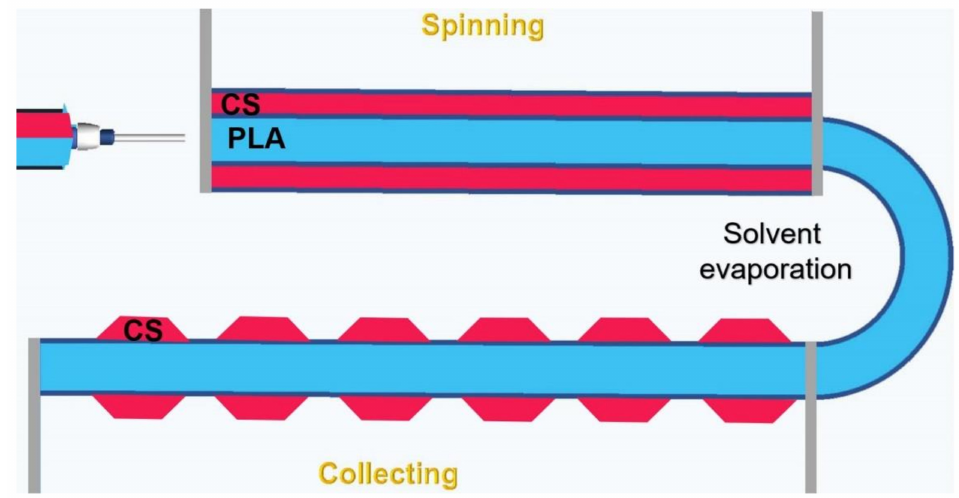
Figure 2. The illustration of preparation of a bicomponent scaffold with island-like structure formed from PLA and chitosan (CS). Reproduced with permission [86]. Copyright © 2021, American Chemical Society.